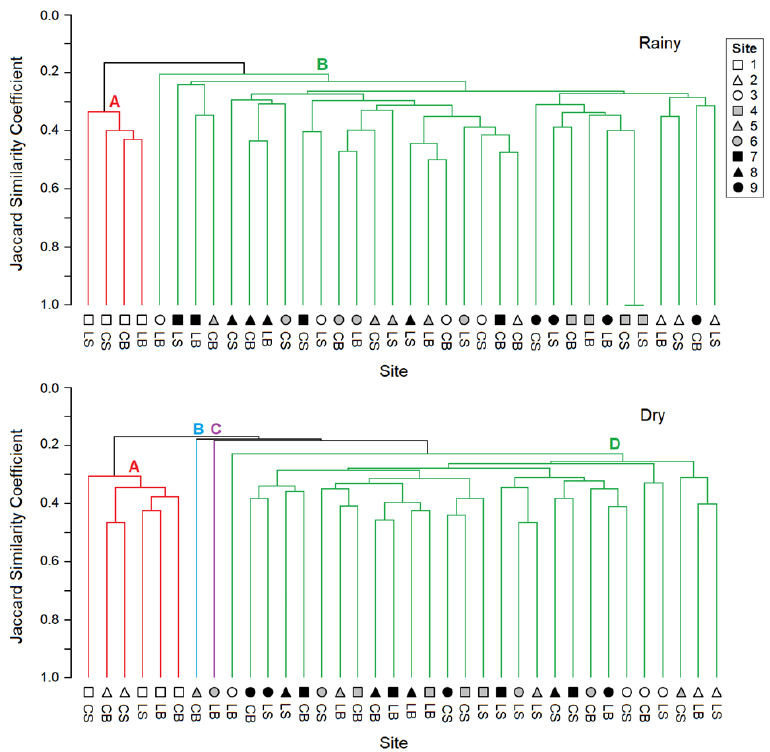
Figure 6. Cluster analysis dendrogram showing the similarity between zooplankton-sampled environments in the Aporé River, Paranaíba River basin, during the different hydrological seasons. Abbreviations: CS, channel-surface; CB, channel-bottom; LS, littoral-surface; LB, littoral-bottom. Different letters (A-D) indicate the formation of different